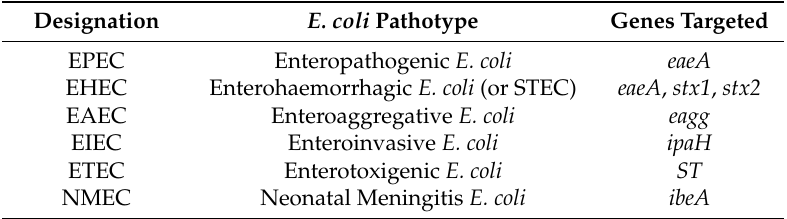
Table 4. Virulence genes investigated and associated Escherichia coli